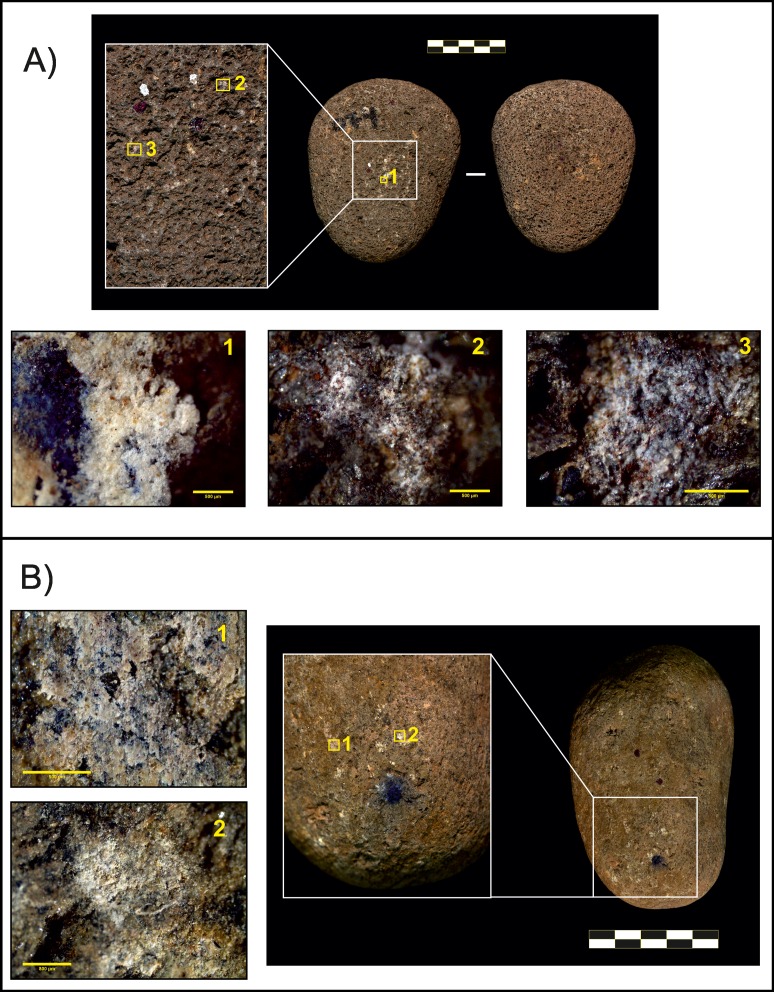
Lava pounding tools.A) Passive element O74. 1. Detail of residues (50×, scale 500 μm); 2 and 3. Impact points (50× and 80×, both scales 500 μm). B) Active element O72. 1. Residues on the working surface (80×, scale 500 μm); 2. Impact point (40×, scale 800 μm).